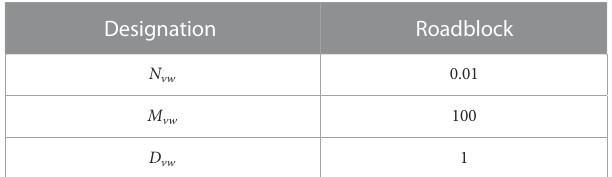
TABLE 2 ‘ Roadblock ’ in M-HCB